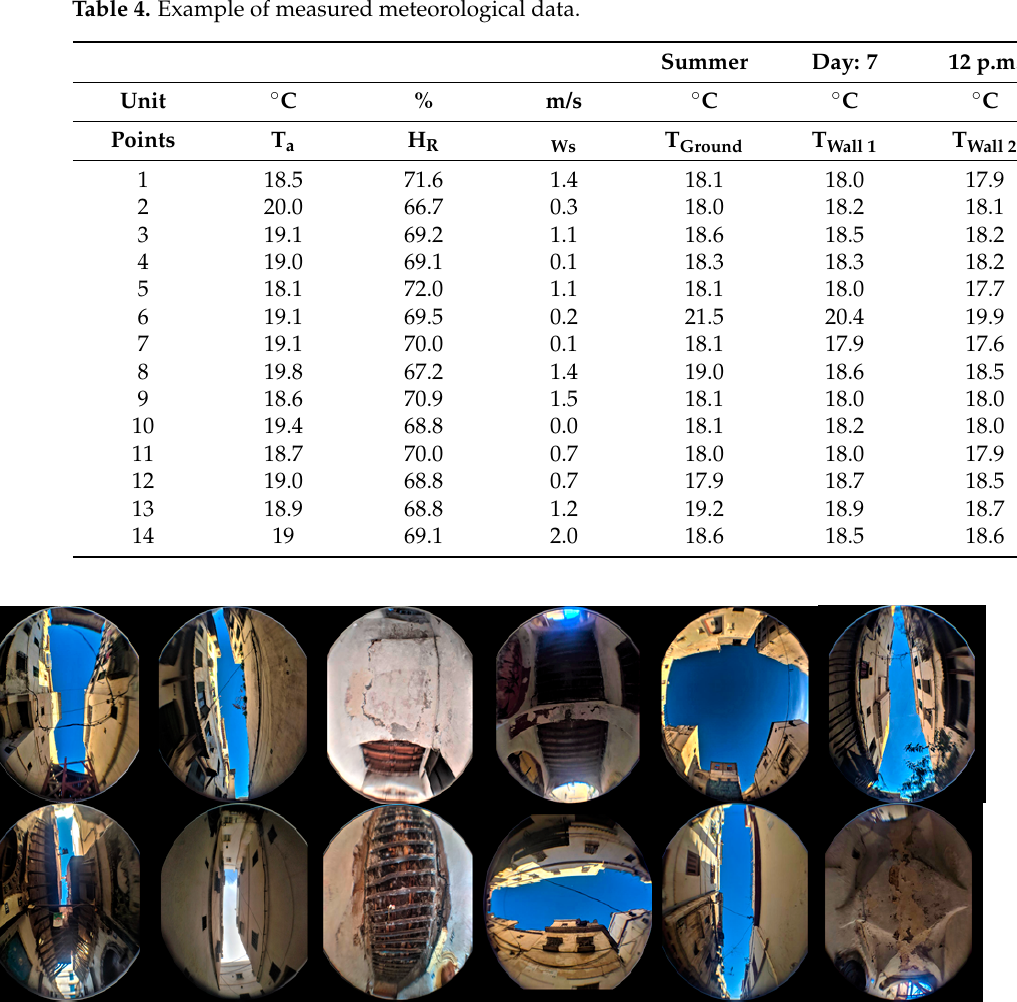
Table 4. Example of measured meteorological data.